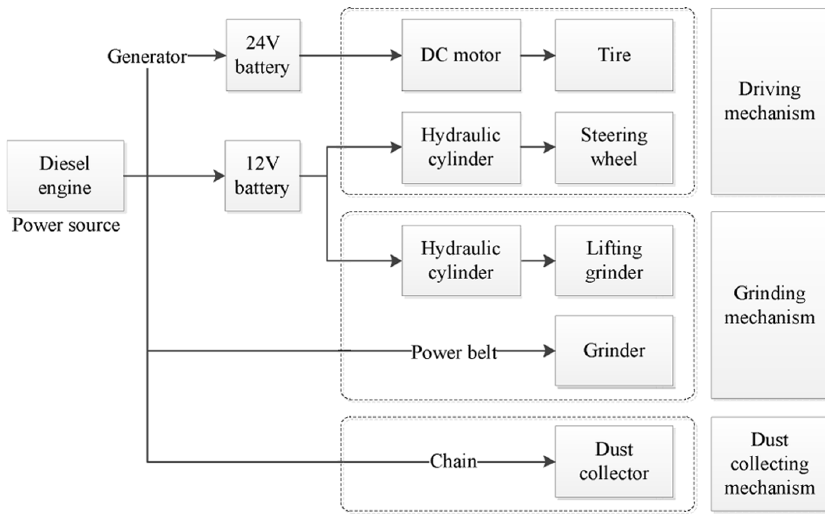
Fig. 2. Hardware system structure of remotely-controlled concrete surface grinding